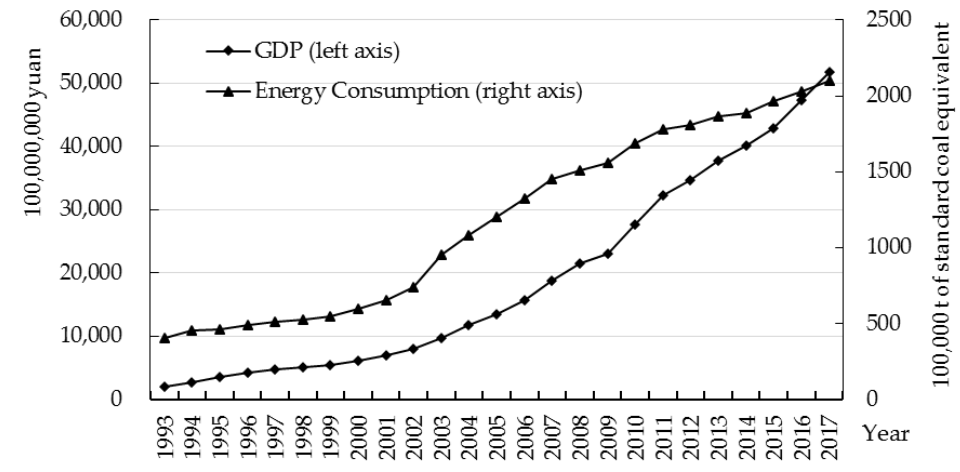
Figure 1. Energy consumption and economic growth in Zhejiang Province (1993 to 2017). Data source: Zhejiang Statistical Yearbook.